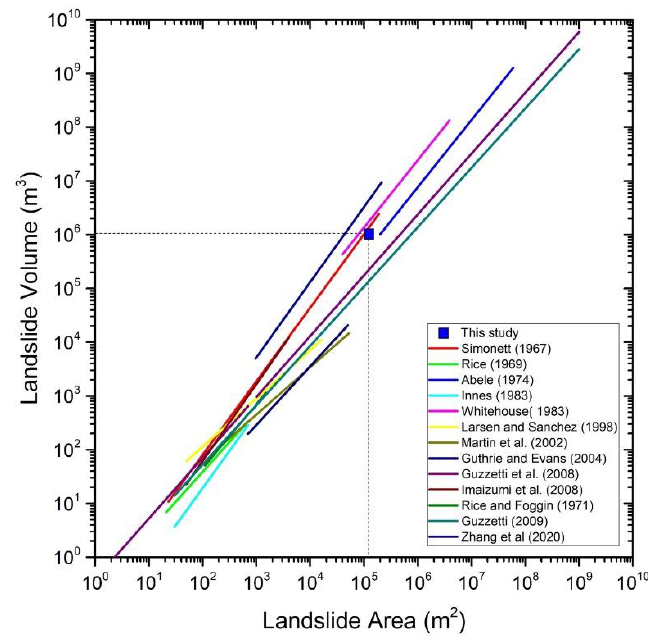
Figure 17. Comparison of the estimated landslide volume from our study with the empirical relationships linking the landslide area ( A L ) and volume ( V L ).